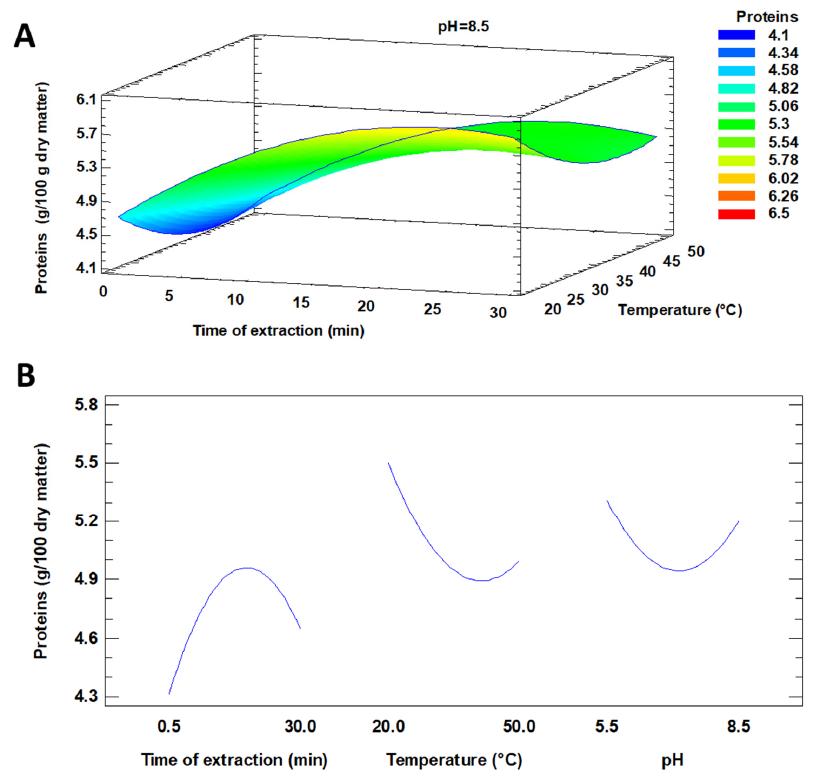
Figure 1. Influence of the different extraction conditions ( A ) and main effects chart for these condi- tions ( B ) on the protein recovery yield (g/100 g dry matter). The least relevant factor (highest p -value) has been set at its optimal value.